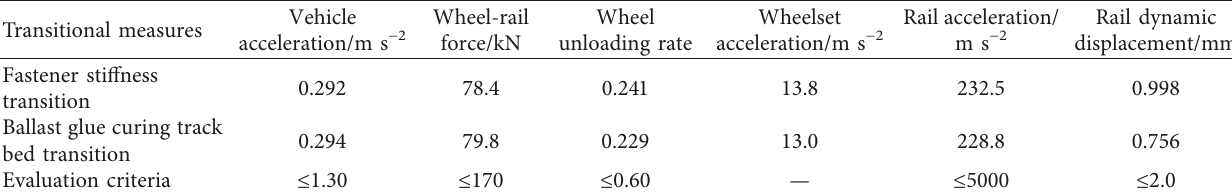
Figure 8: Dynamic response curve of vehicle-rail system under ballast glue cured track bed. (a) Vertical acceleration of vehicle body. (b) Wheel-rail force. (c) Wheel load reduction rate. (d) Wheelset vertical acceleration. (e) Rail vertical acceleration. (f) Rail dynamic displacement. Table 7: Summary of the maximum dynamic response of vehicle-rail